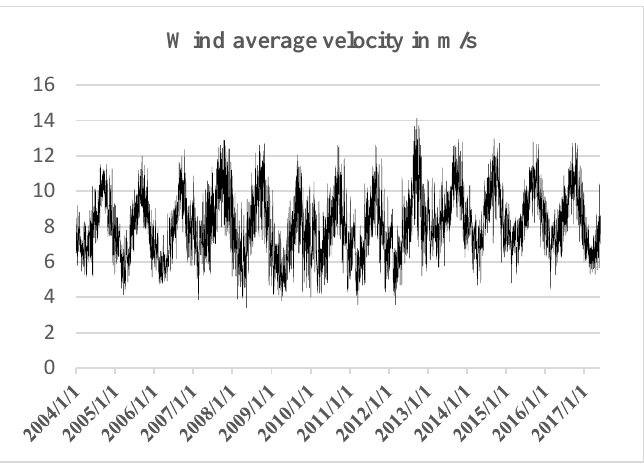
Figure 2. Time series components of the wind speed of the database in days. Source: http://sonda.ccst.inpe.br/basedados/. Table 1. Pattern of forecast horizons .